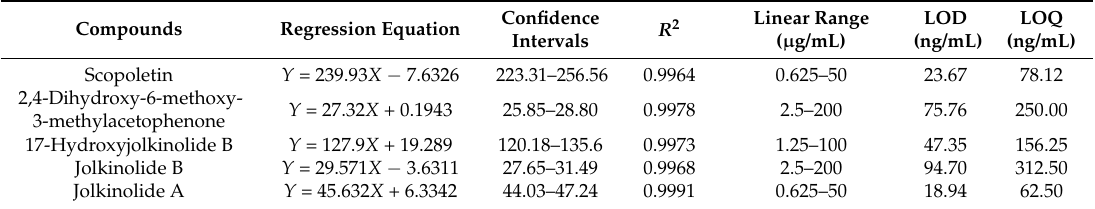
Table 3. CalibrationcurvesofScopoletin,2,4-Dihydroxy-6-methoxy-3-methylacetophenone,17-HydroxyjolkinolideB, Jolkinolide B, and Jolkinolide A in Euphorbia fischeriana for